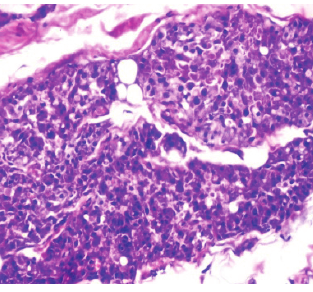
FIGURE 7 - Inflammatory reaction in Group